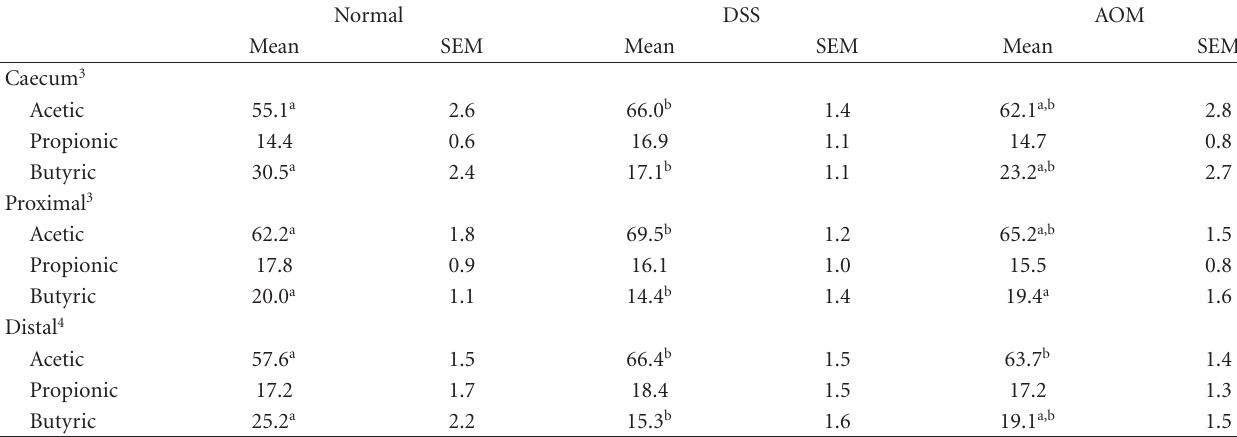
Table 5: Short-chain fatty acids. Distribution between acetic, propionic, and butyric acid (%) in the gut content of rats in di ff erent treatment groups 1,2